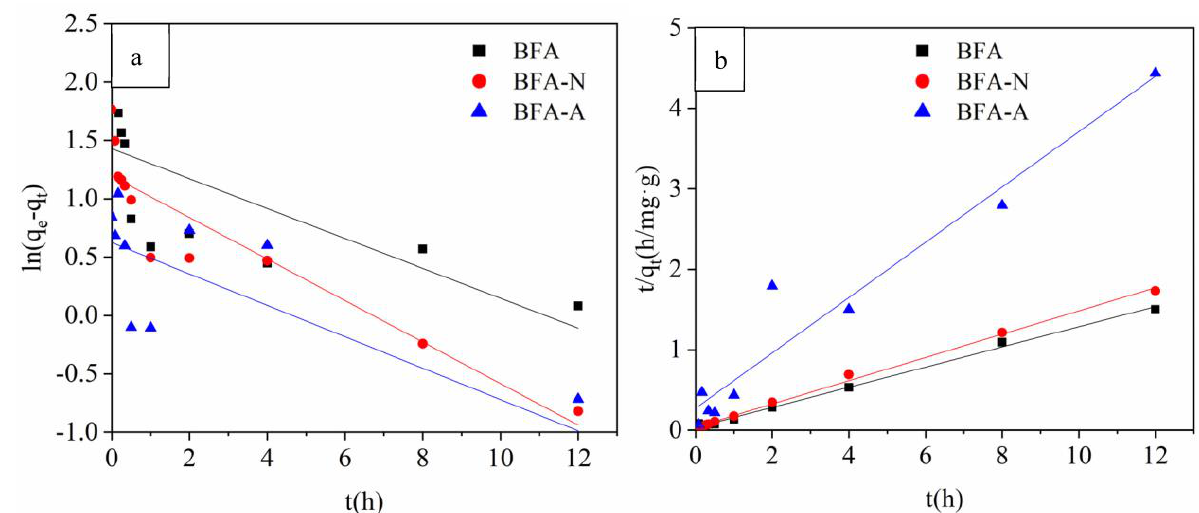
Table 2. Absorption kinetic fitting parameters of Cd by BFA, BFA-N, and BFA-A.